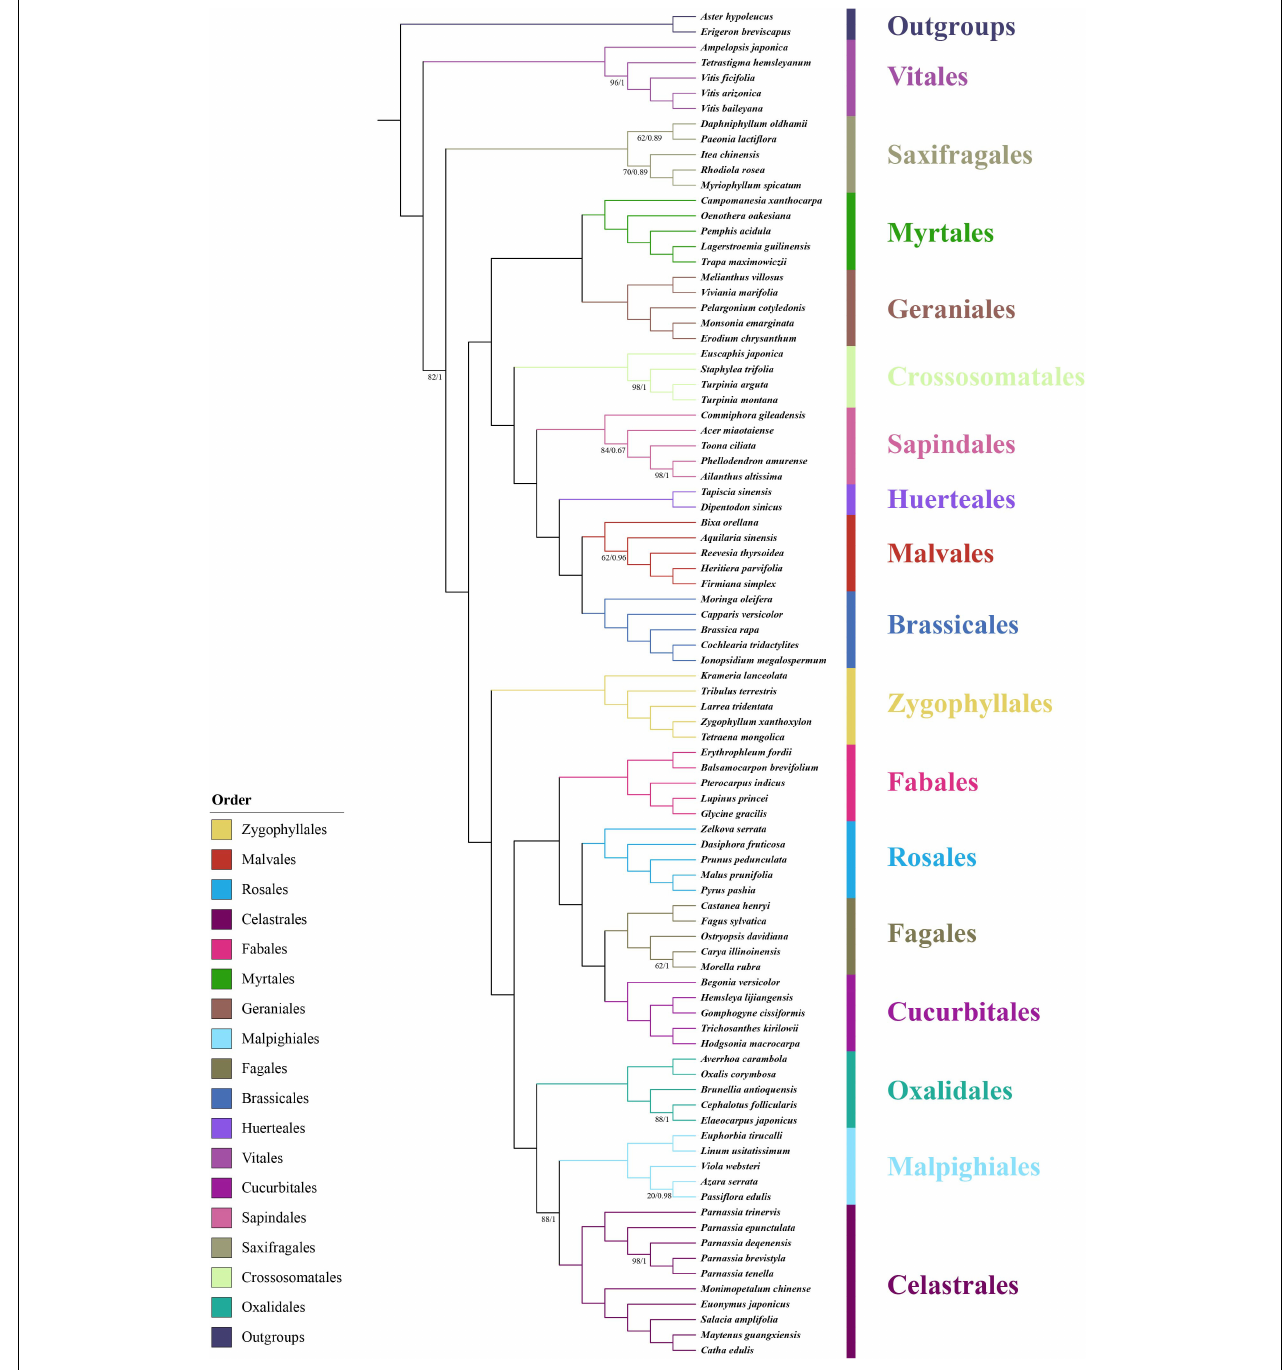
FIGURE 1 | Phylogenetic position of the genus Parnassia in Superrosids revealed by the concatenated data sets of 71 CDSs. Numbers associated with branches are ML bootstrap values and Bayesian posterior probabilities. Nodes without numbers indicate 100% bootstrap support and 1.0 posterior probability.